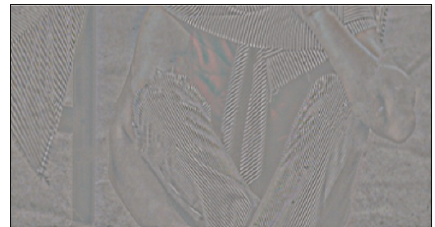
Figure 9: A chosen part of the completed texture